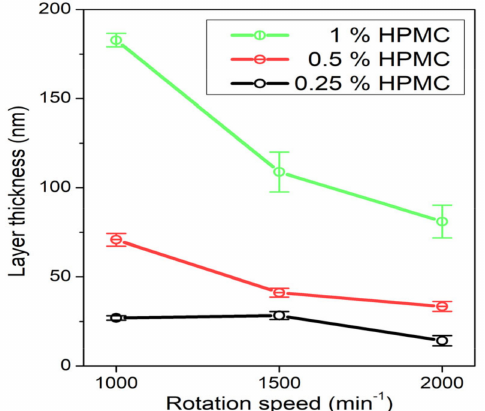
Figure 9. Dependence of spin-coated film thickness on the rotation speed of the spin-coater table for the samples prepared from 0.25%, 0.5% and 1% HPMC